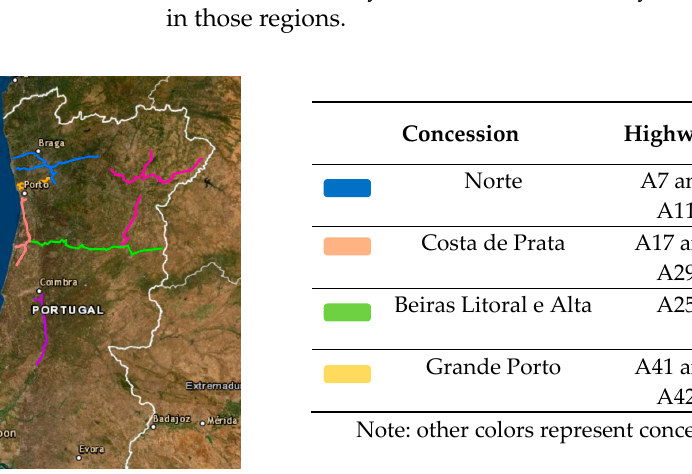
Figure 2. Number of sections for concession, highways, and districts.